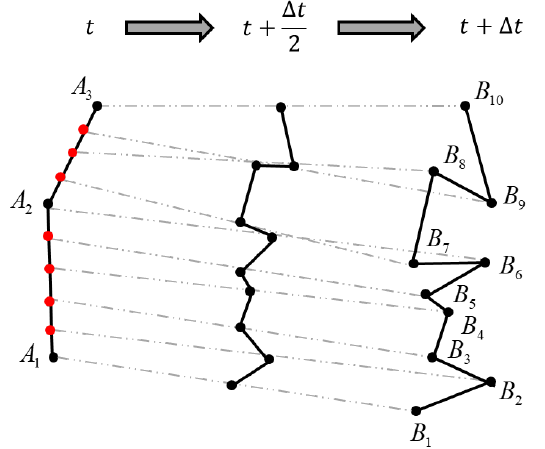
Figure 4. Additional points facilitating one-to-one transformation (marked by red color).